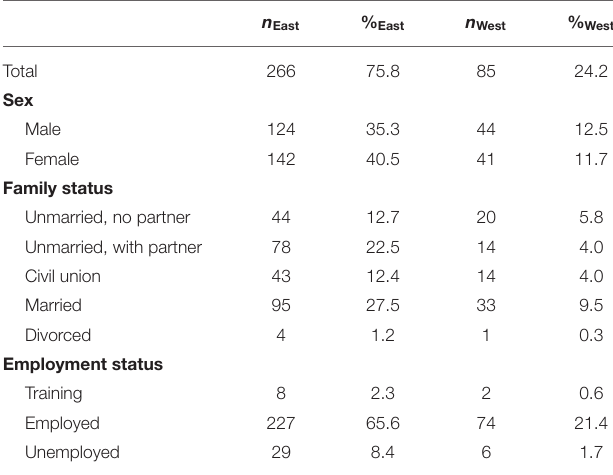
TABLE 1 | Sociodemographic variables of the sample (in